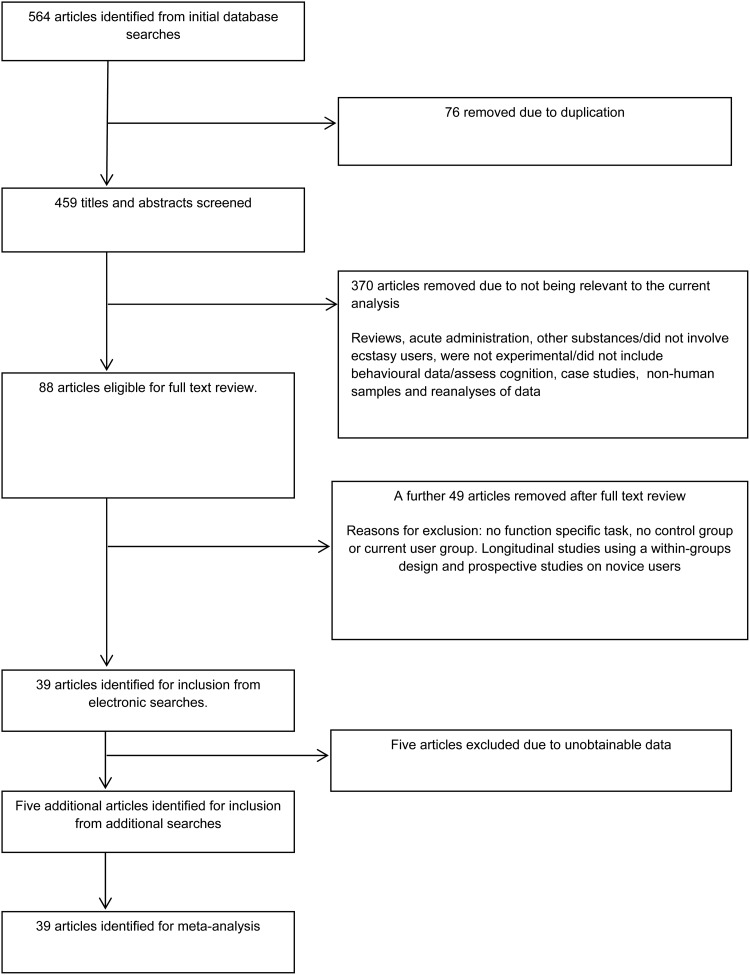
Meta-analysis search results and flow chart.